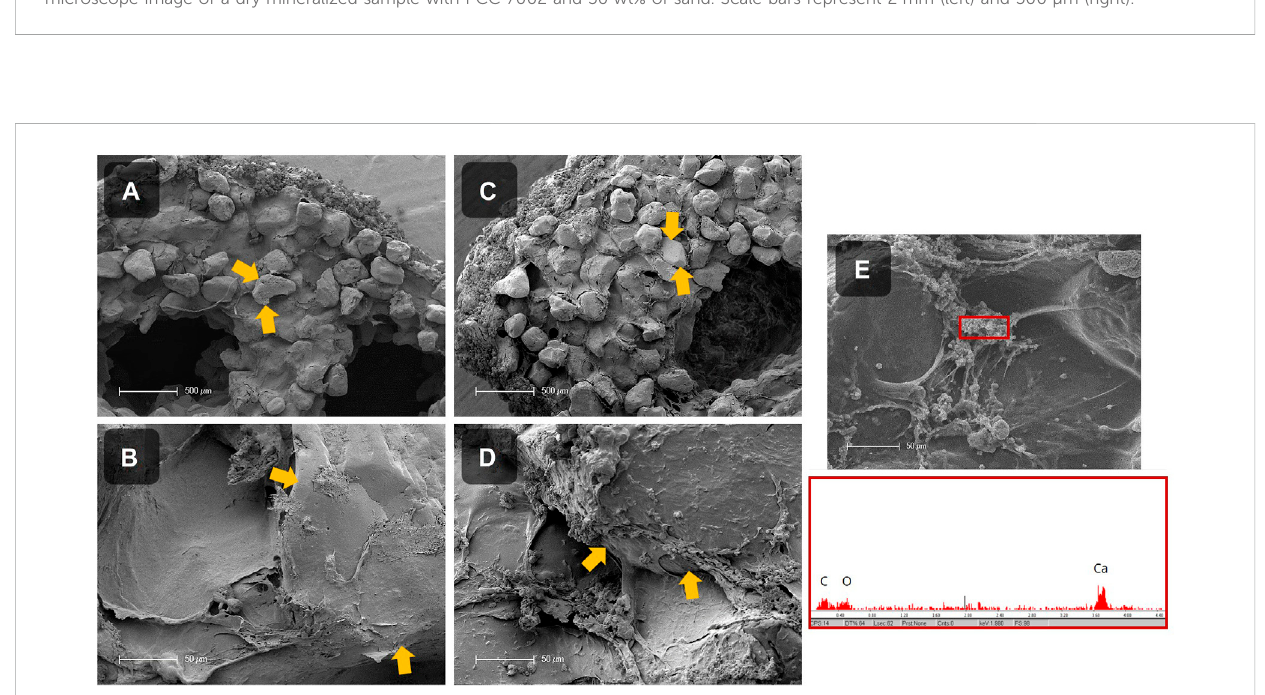
FIGURE 8 SEMimagesofthecrosssectionofdried,mineralizedscaffoldswithoutcells(=abioticcontrol; (A,B) )andwithPCC7002(=LBM; (C – E) )with50 wt% ofsand.Sandparticlesaremarkedwithyellowarrows.EDXmeasurementofprecipitatesinsideofthescaffoldwithPCC7002,showingacalciumpeak (E) . Scale bars (A, C) = 500 μ m, scale bars (B, D, E) = 50 µm.